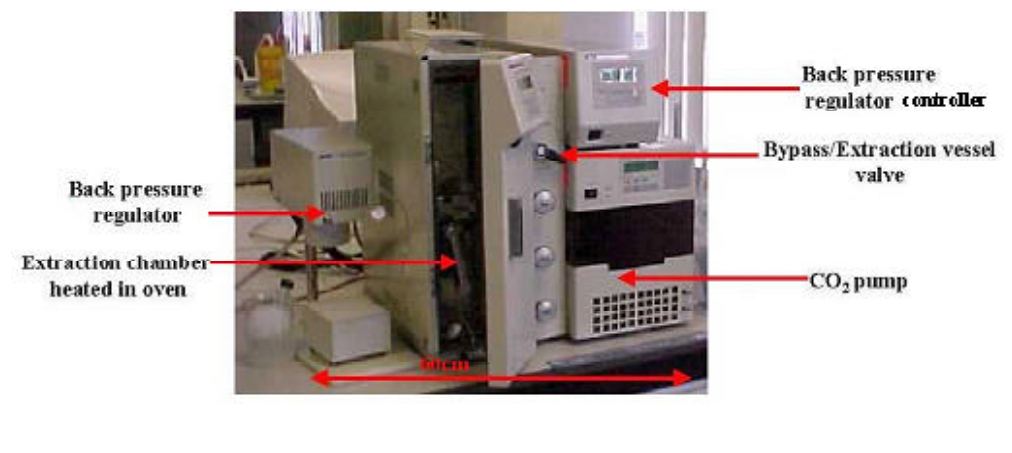
FIGURE 1. Field-based SFE system with, from the right to the left, the CO